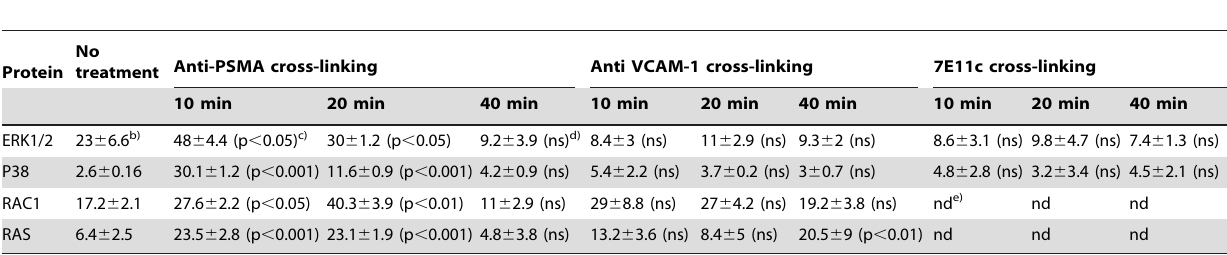
Table 1. Kinetics of ERK1/2, p38, RAC1 and RAS activation in LNCaP cells following cross-linking of anti-PSMA, anti-VCAM-1 or 7E11c mAb a) .